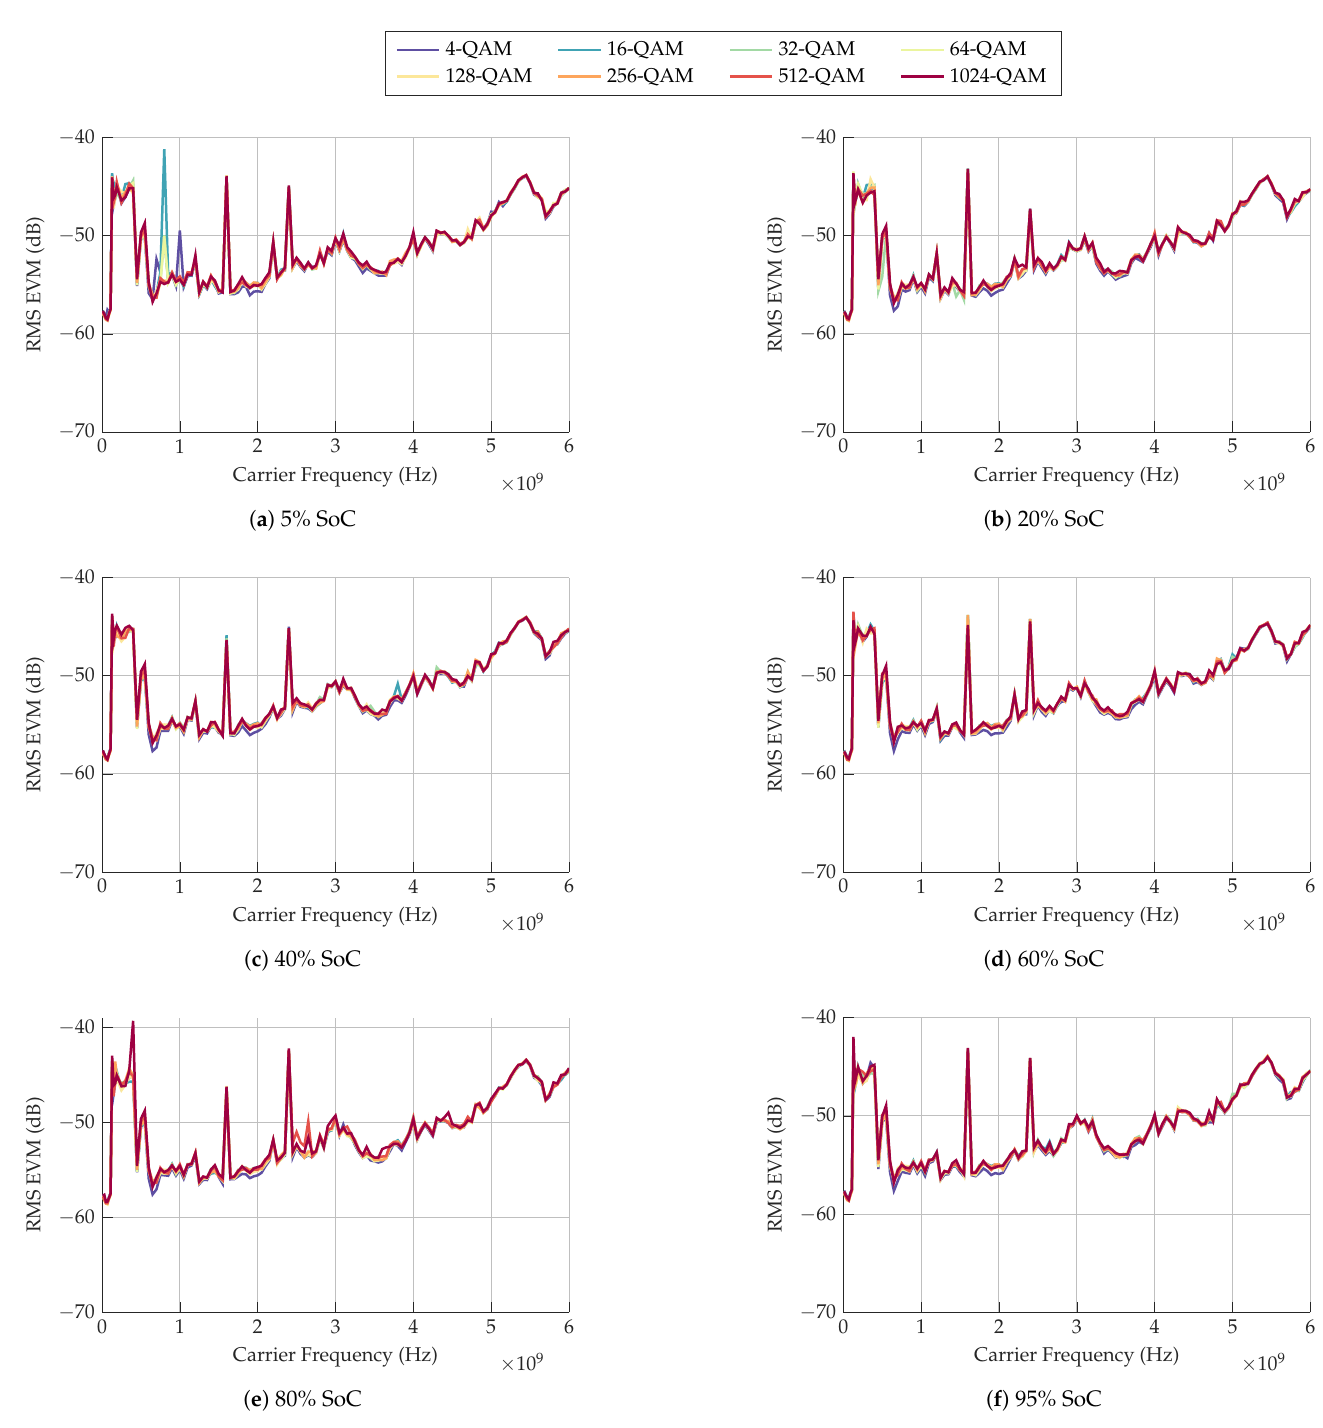
Figure A4. RMS EVM for QAM-signals transmitted with a peak output power of a Li-ion cell at various